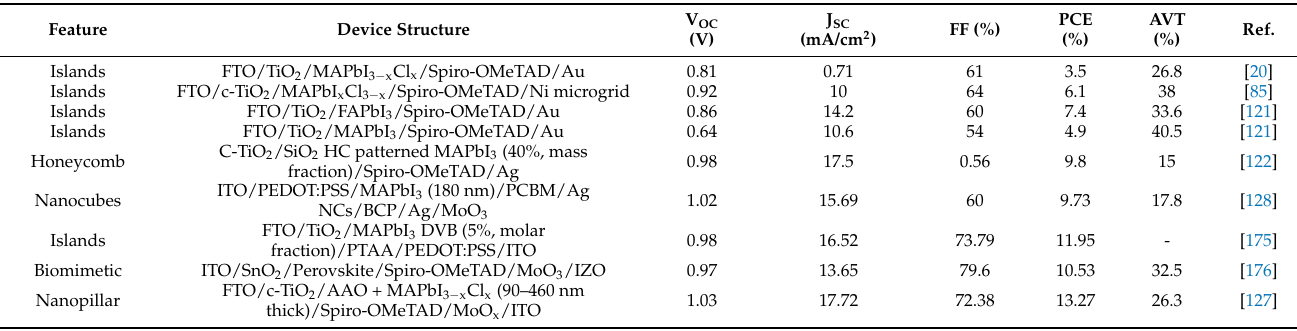
Table 3. Summary of representative ST-PSCs with different micro- and